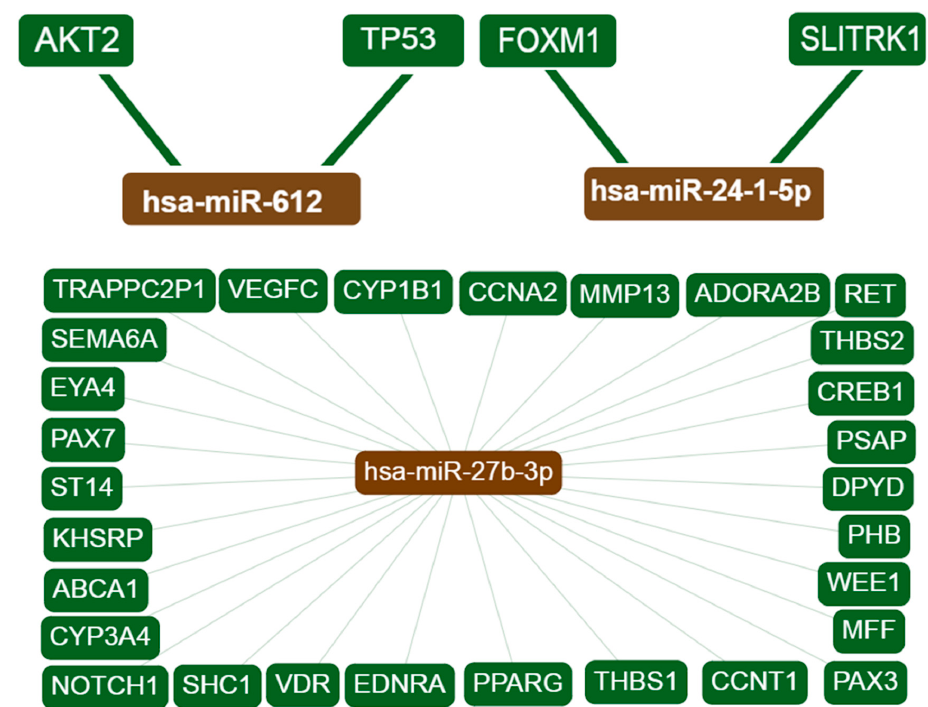
Figure 1. Interaction network of the target genes. Only interactions with strong evidence are shown. hsa-miR-27b-3p displayed 29 interactions while hsa-miR-612 and hsa-miR24-1 show 2 interactions each. hsa-miR-647, hsa-miR-3654, and hsa-miR-1914 showed no interactions with any genes.